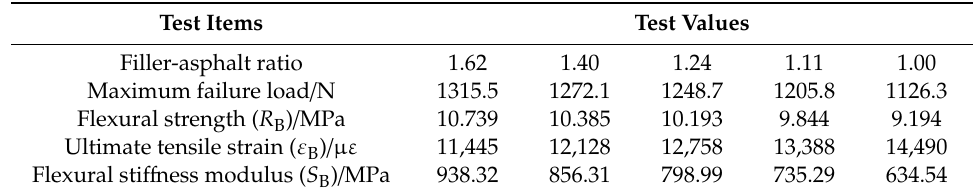
Table 14. Results of the low-temperature bend test.